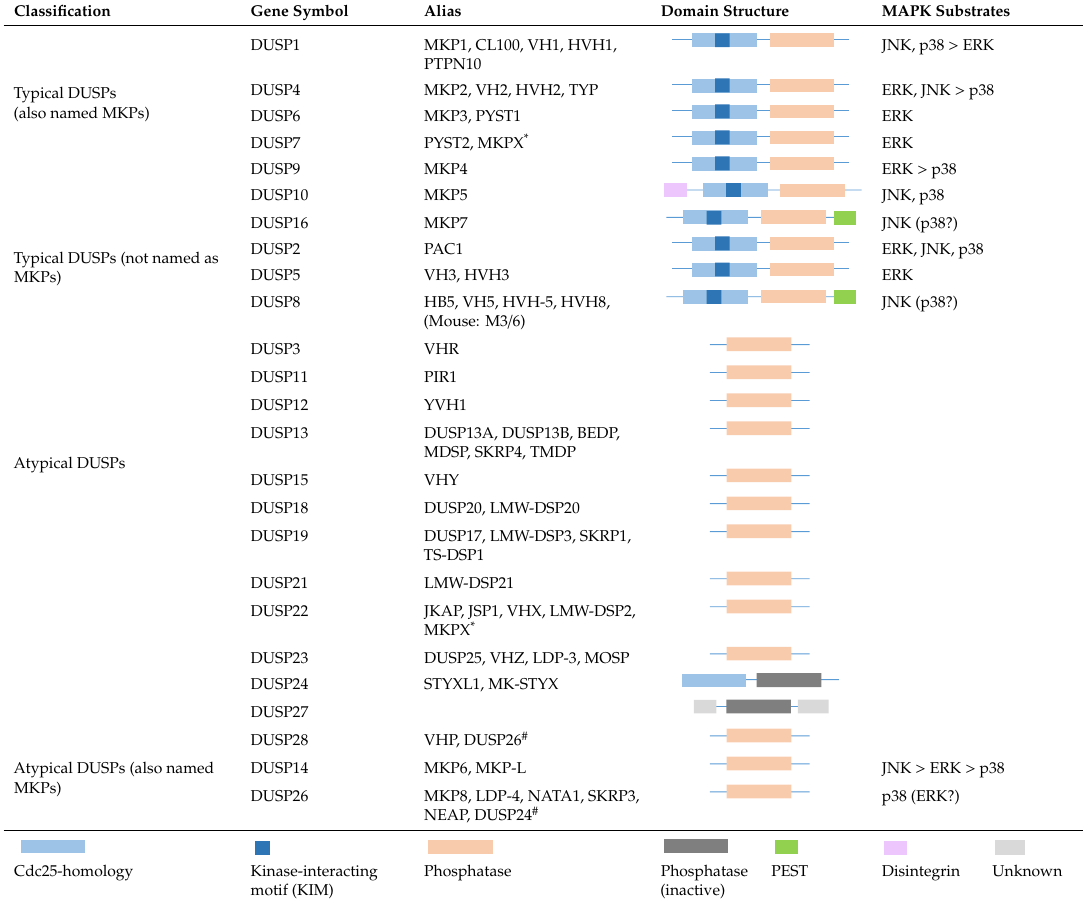
* , MKPX is a duplicate name for both DUSP7 and DUSP22. # , DUSP24 and DUSP26 are renamed to DUSP26 and DUSP28, respectively. Domain structures are annotated from the Ensemble database.